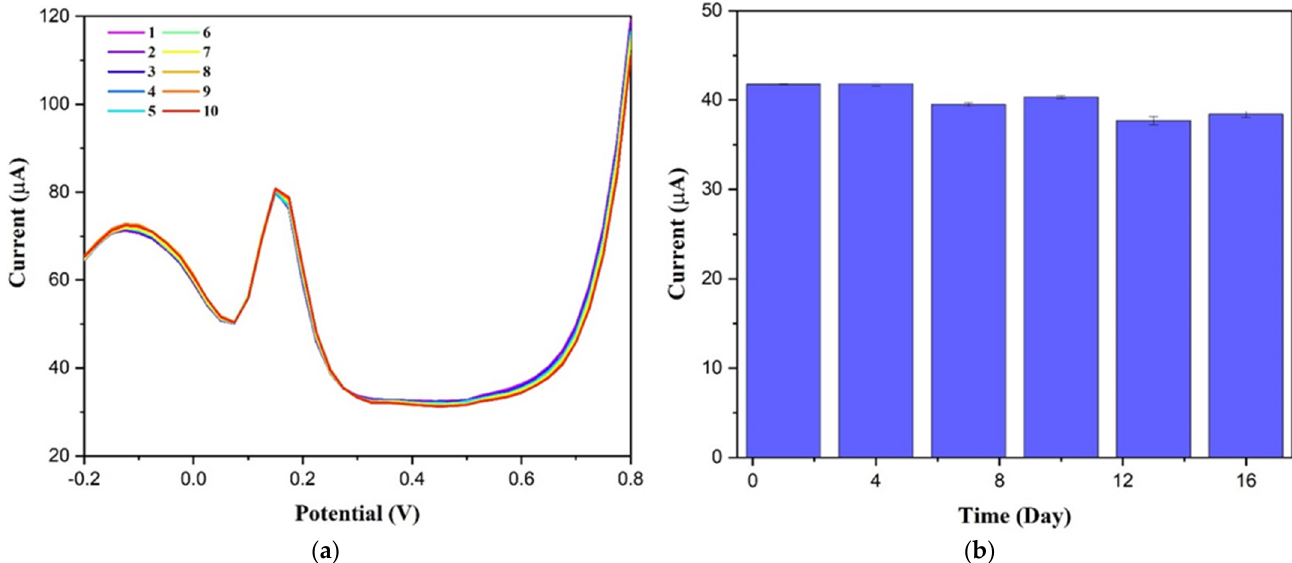
Figure 11. ( a ) Peak currents of DPVs with total ten experiments. ( b ) Recycling stability tests over as-obtained 1% Pd-5% Au/MWCNT at room temperature.